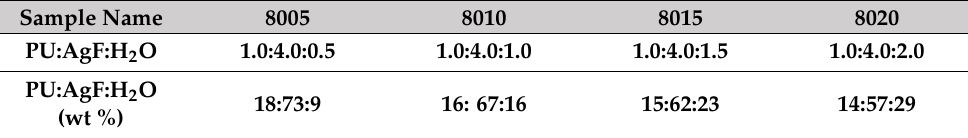
Table 1. Different numbers correspond to different proportions of homemade silver